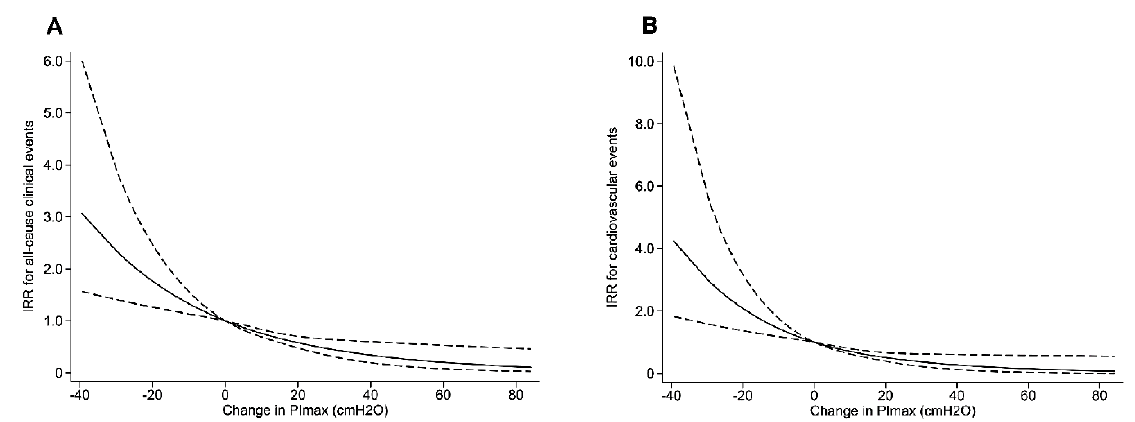
Figure 2. Cubic spline curves of crude relationships between change in respiratory muscle strength and incidence rate of end-points. ( A ) All-cause events and ( B ) cardiovascular events; Dash lines, 95% confidence interval. IRR, incident rate ratio; PI max , maximal inspiratory pressure.